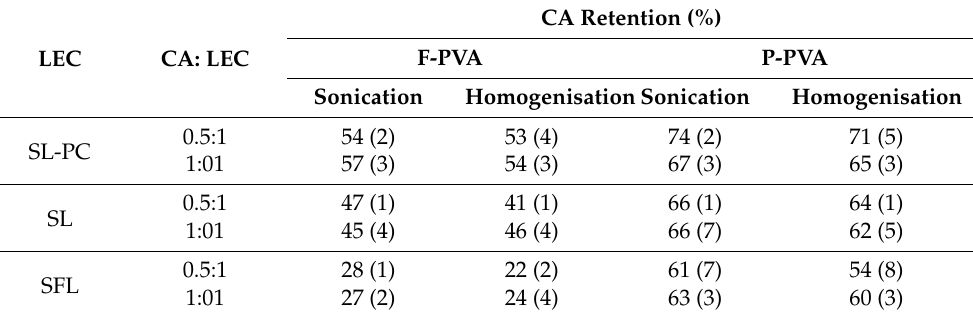
Figure 2. Development over time of the hydrodynamic diameter (D H ) and the ζ -potential of liposomes from soy lecithin enriched in phosphatidylcholine (SL-PC), soy lecithin (SL) and sunflower lecithin (SFL), carvacrol-free (F-L) or CA-loaded (CA-L) (CA: LEC: 1:1) liposomes, obtained by sonication (S) or rotor-stator homogenisation (H). Table 2. Carvacrol retention (ratio of determined carvacrol with respect to the incorporated amount, in percentage) in dry PVA films for fully (F) and partially (P) hydrolysed polymer and different carvacrol-loaded liposomal